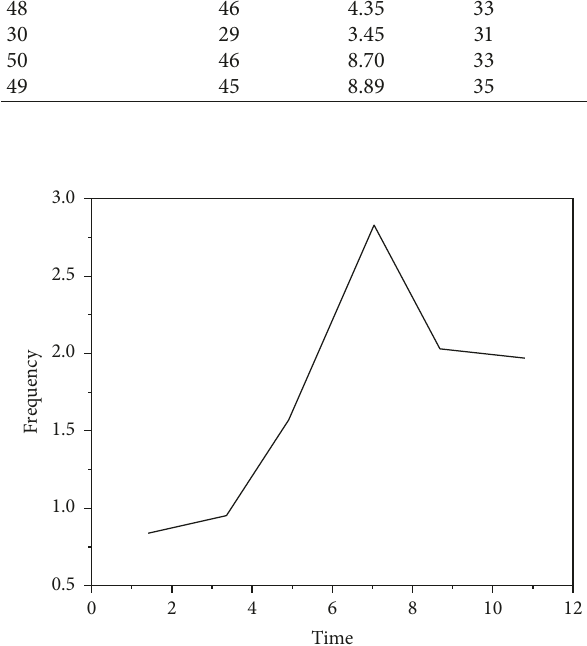
Figure 6: Test results of sensor data updating, alarm response, and average time of data